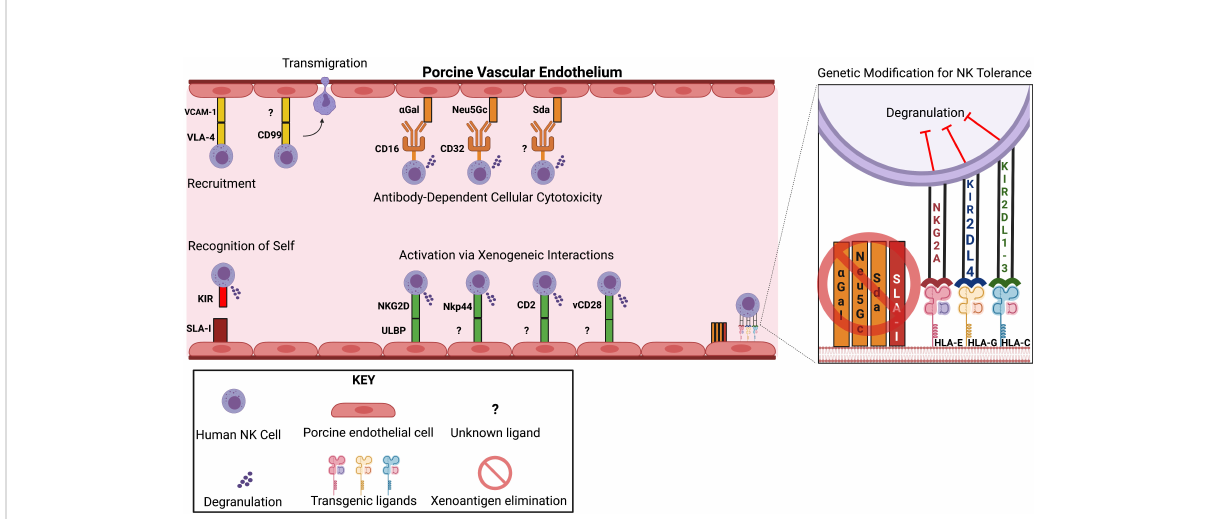
FIGURE 1 Genetic Modi fi cations that Reduce NK Cell-directed Cytotoxicity. Top left: Recruitment occurs due to adhesive interactions between endothelial ligands and NK cell receptors. Transmigration is mediated by interactions between CD99 and unknown ligands on porcine endothelial cells. Top middle: Antibody-dependent cellular cytotoxicity (ADCC) present upon NK cell recognition of preformed IgG antibodies directed against the xenoantigens a Gal, Neu5Gc, and Sda. Bottom left: Failed self-recognition due to non-homology between SLA I and HLA I molecules. Bottom middle : NK cell receptor activation results from interactions with unknown porcine ligands. Right : Summary of current genetic modi fi cation proposed to reduce NK cell-mediated